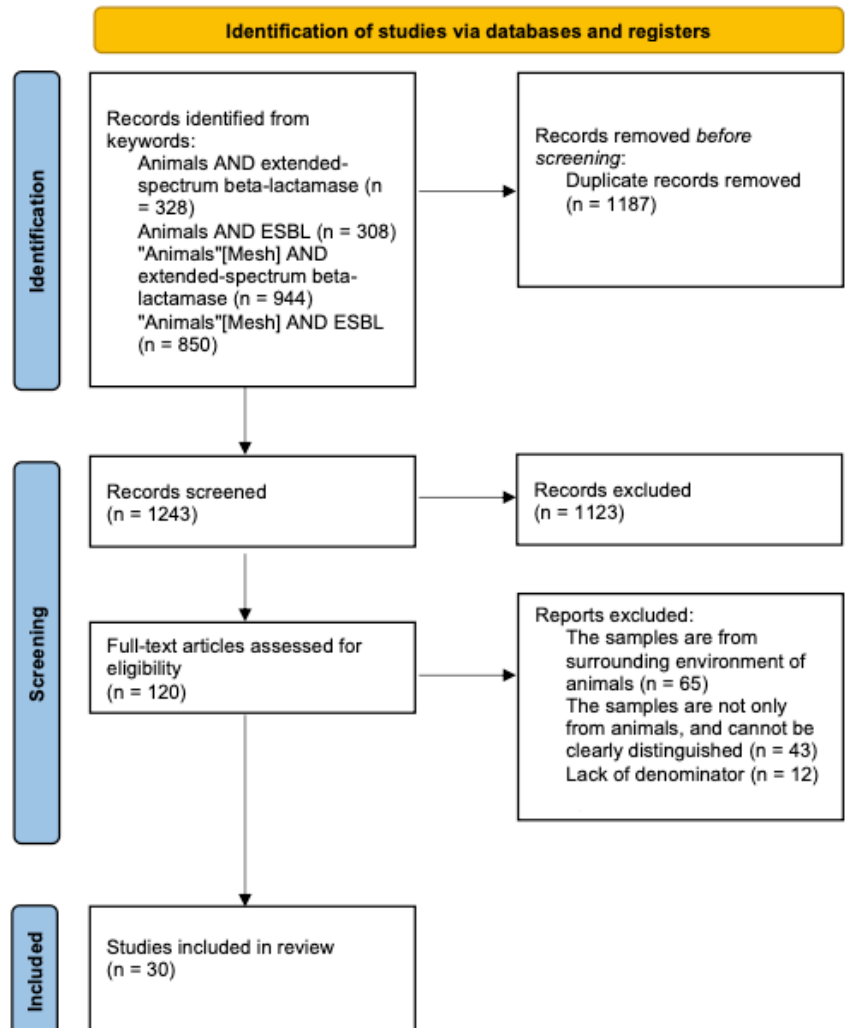
Figure 2. Flow diagram of the study selection process.